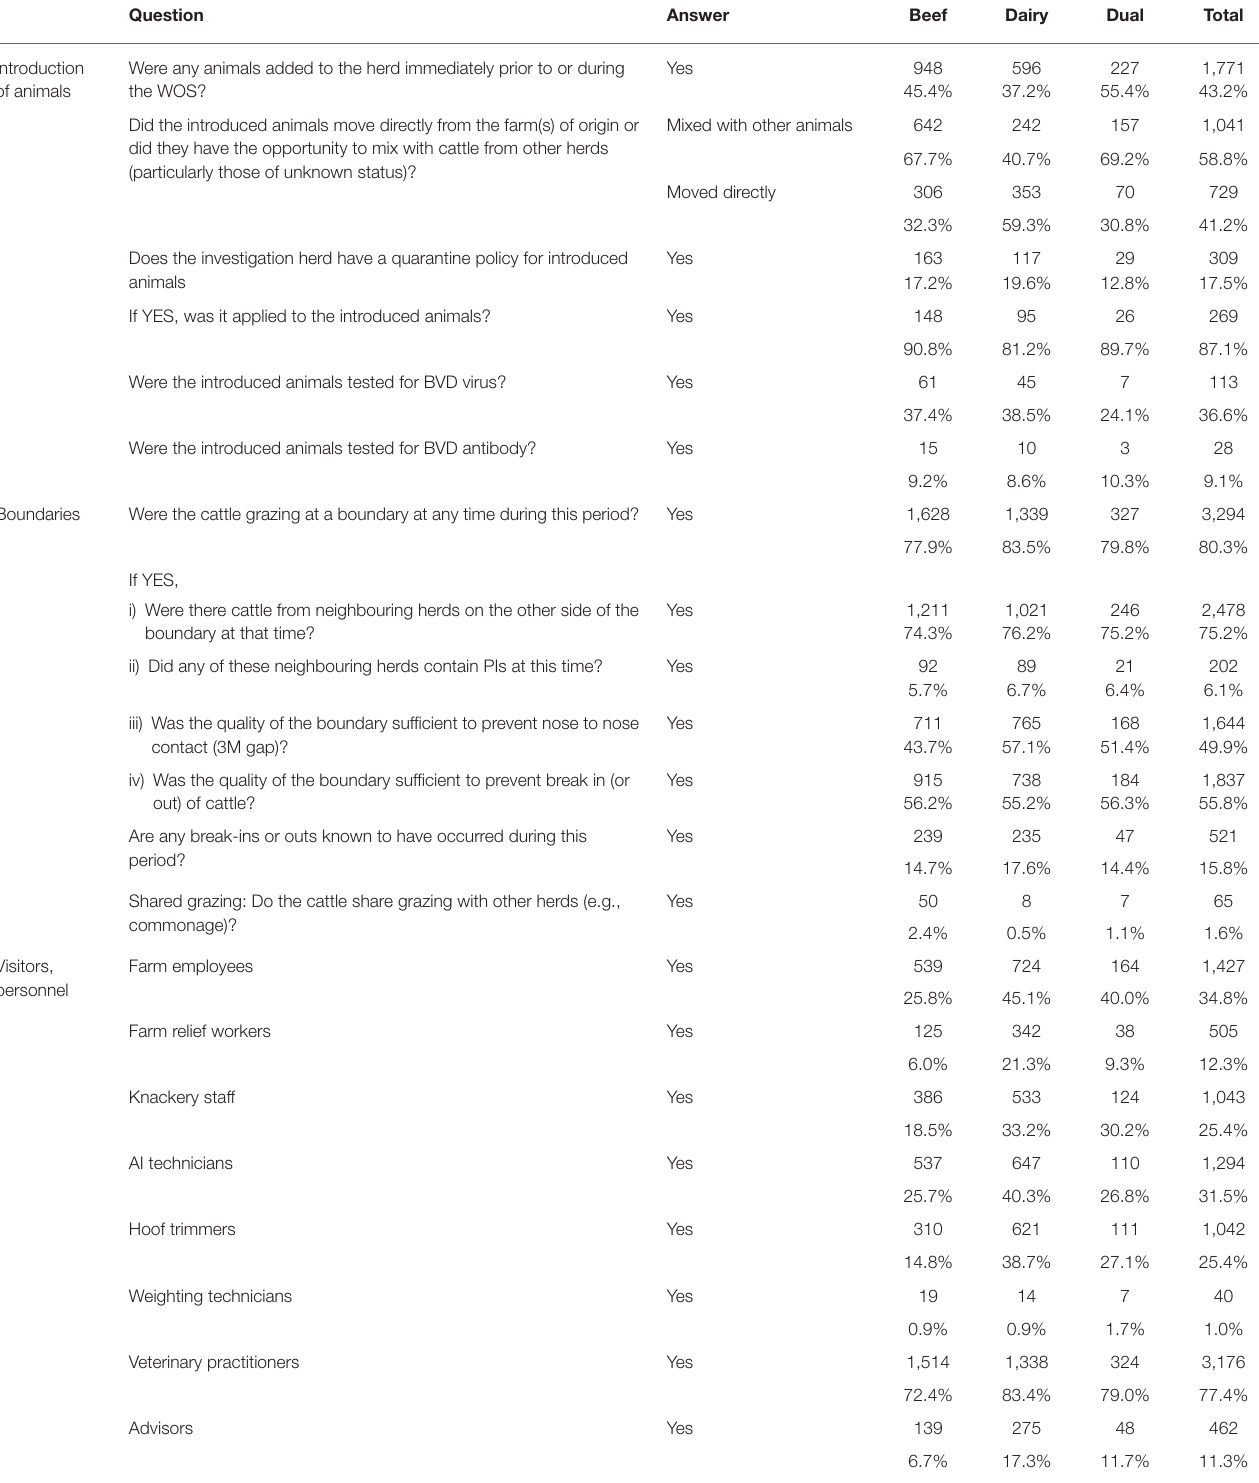
TABLE 3 | Number (%) of positive responses to questions related to the introduction of animals, boundaries, visitors and personnel, and herd owner coming into contact with the cattle overall and by herd type.